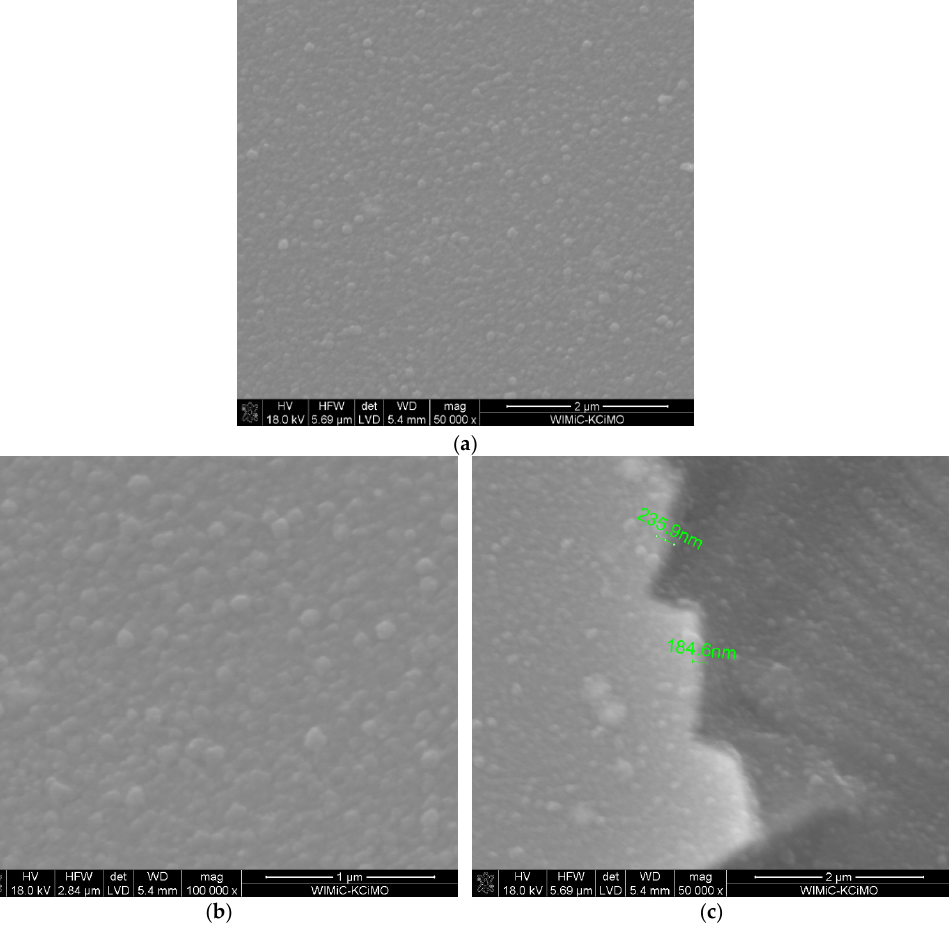
Figure 3. Microstructure of the layer synthesised at a temperature of 650 ◦ C on tubular substrate at dif- ferent magnifications: 50,000 × ( a ) and 100,000 × ( b ) and the cross-section: the layer–the substrate ( c ). The content of Sc(tmhd) 3 in the gas mixture: 14 mol.%. Total gas pressure: 10 5 Pa. Deposition time: 20